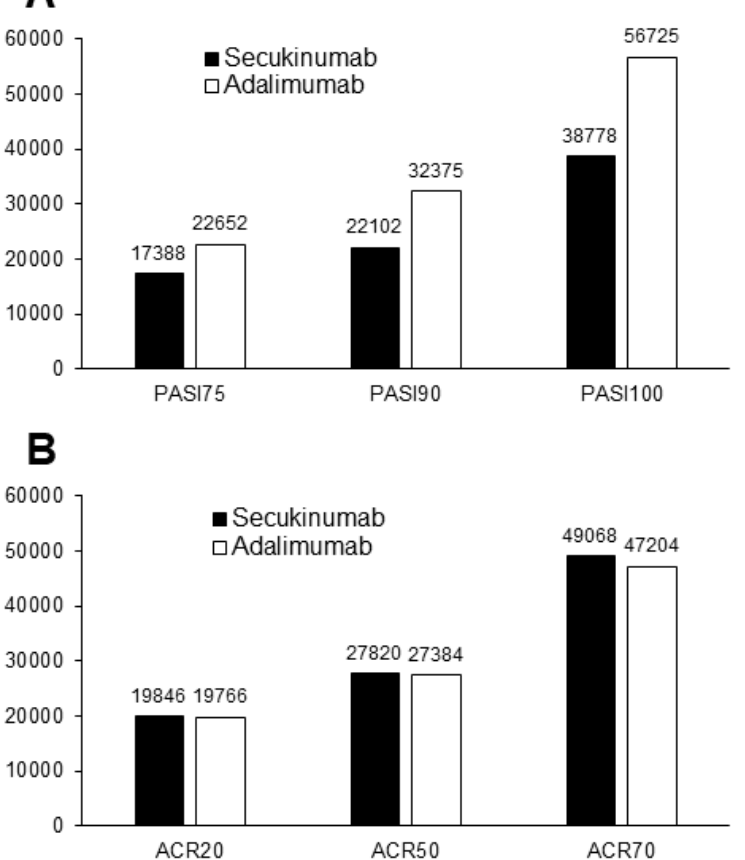
Figure 1. Cost per responder analysis for PASI 75/90/100 ( A ) and ACR 20/50/70 ( B ) in patients receiving secukinumab (black bars) and adalimumab (white bars) at week 52 (in Euro).